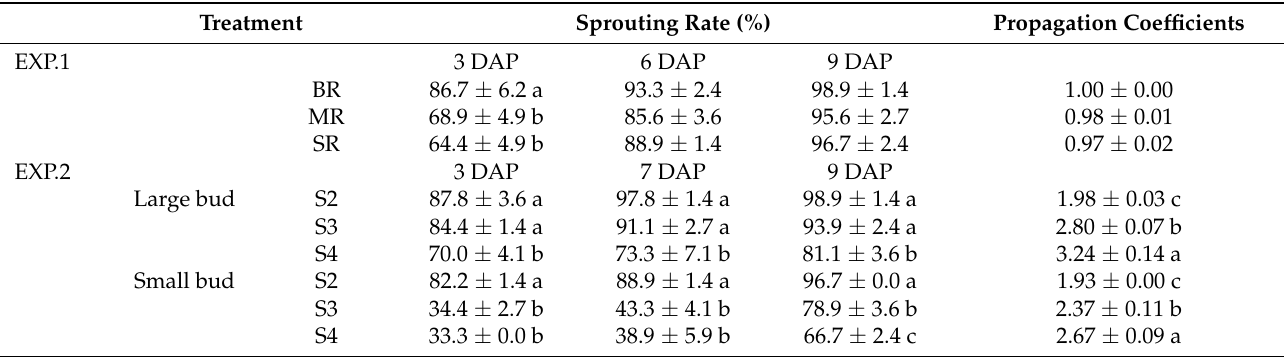
Table 1. The sprouting rate of apical buds on propagules during first 9 days and the propagation coefficients of each treatment in EXP.1 and EXP.2. Treatment Sprouting Rate (%) Propagation